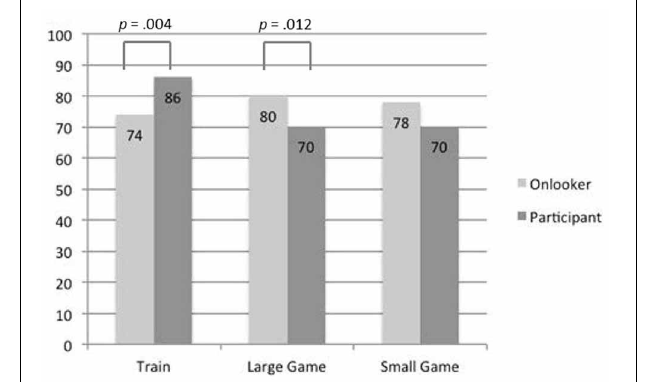
FIGURE 1 | Mean moral rightness ratings ( − 3 Definitely wrong to + 3 Definitely right). FIGURE 2 | Percentage of subjects who judged that Peter should pull the lever/press the button.